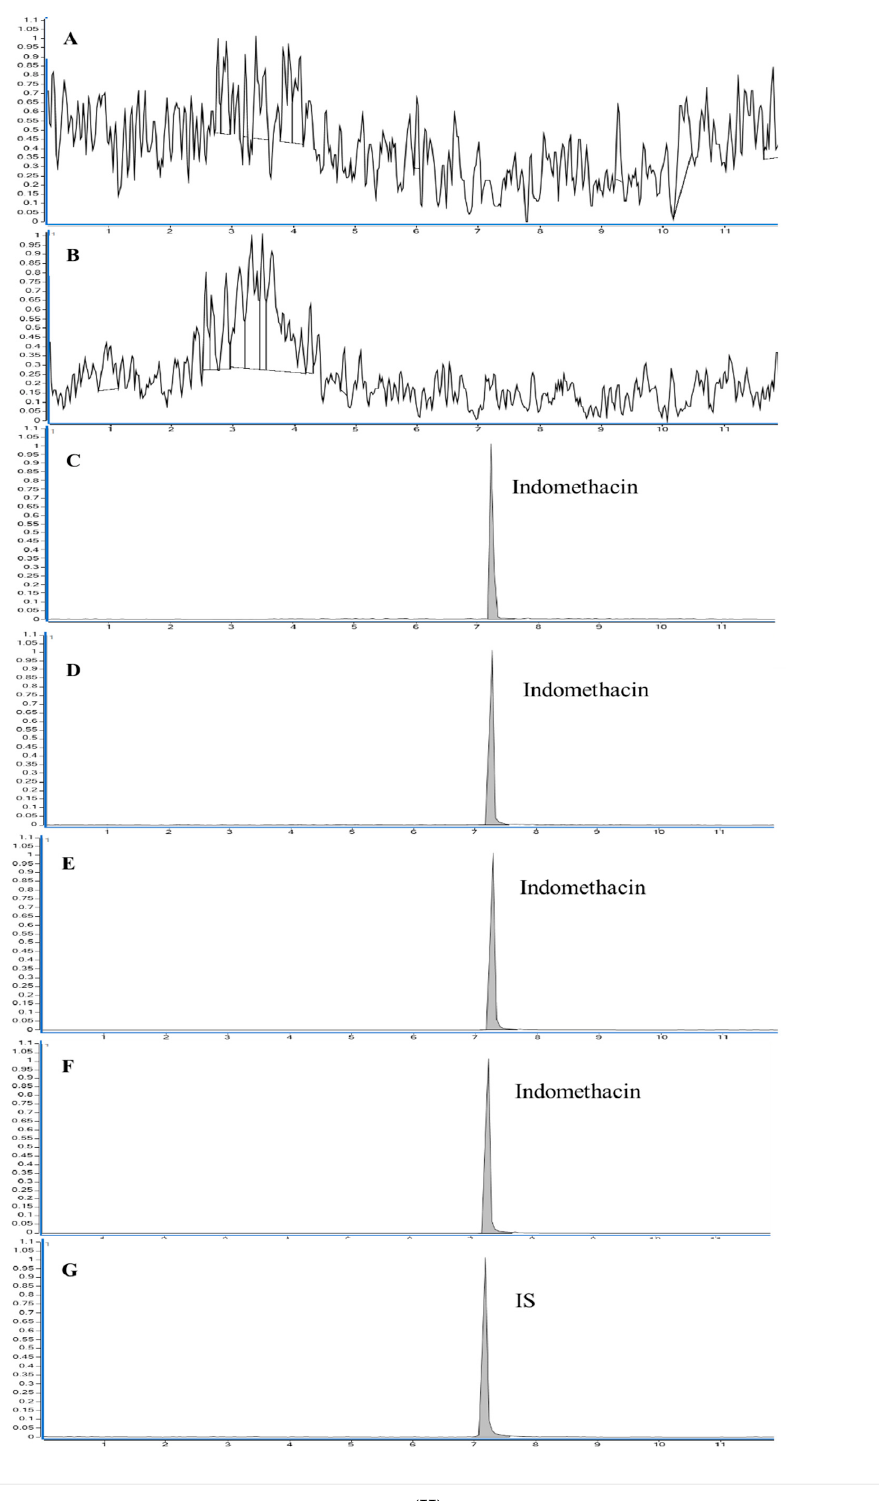
Figure 8. ( I ) Selected ion chromatograms of ( A ) solvent blank ( B ) plasma blank ( C ) LLOQ (1